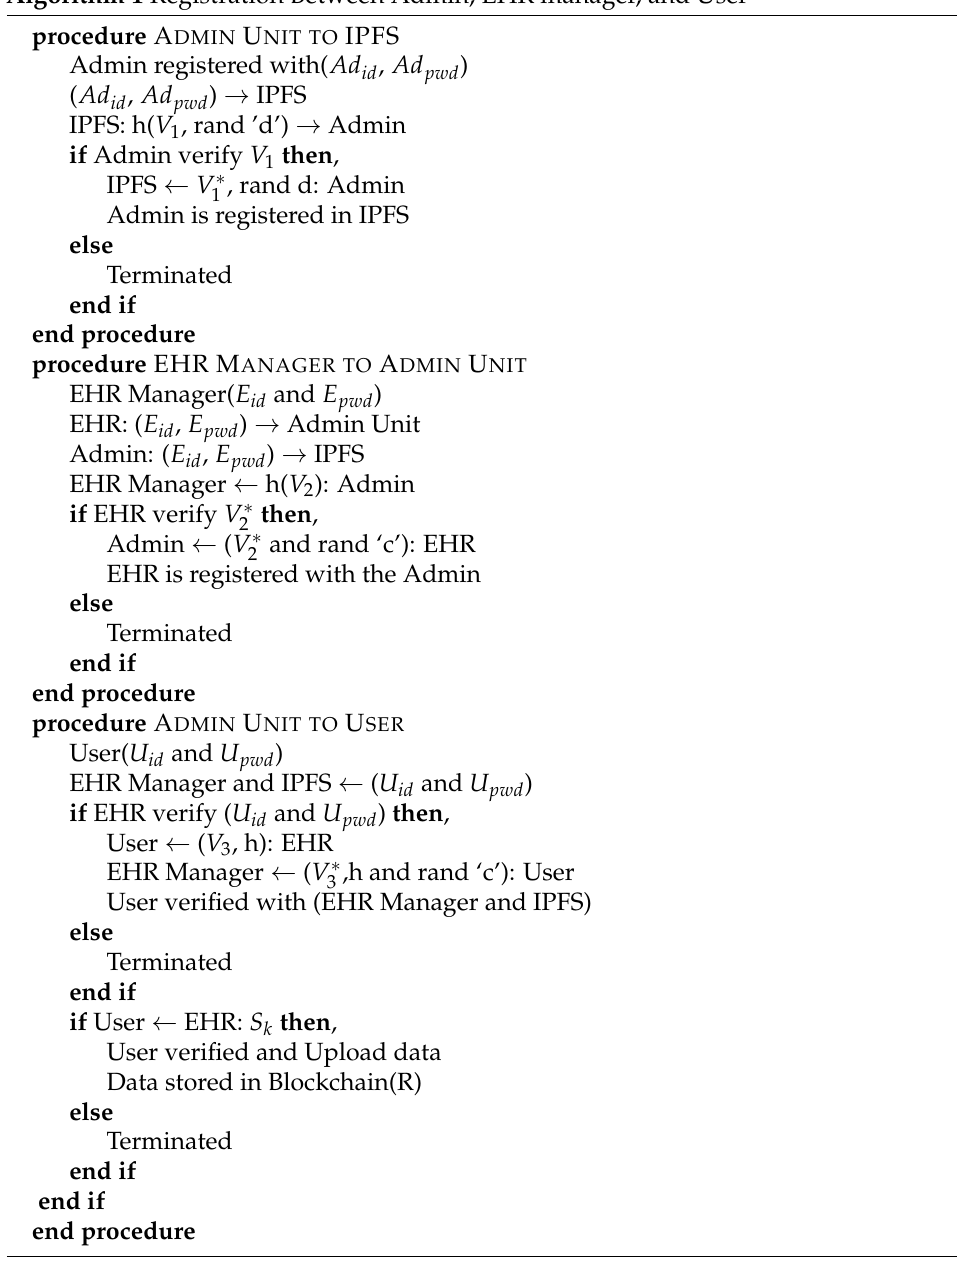
Algorithm 1 Registration Between Admin, EHR manager, and